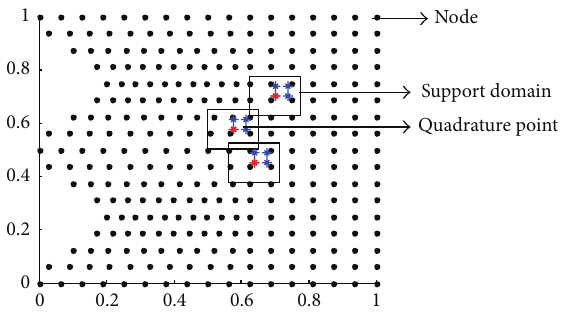
Figure 2: Selection of support domain for a quadrature